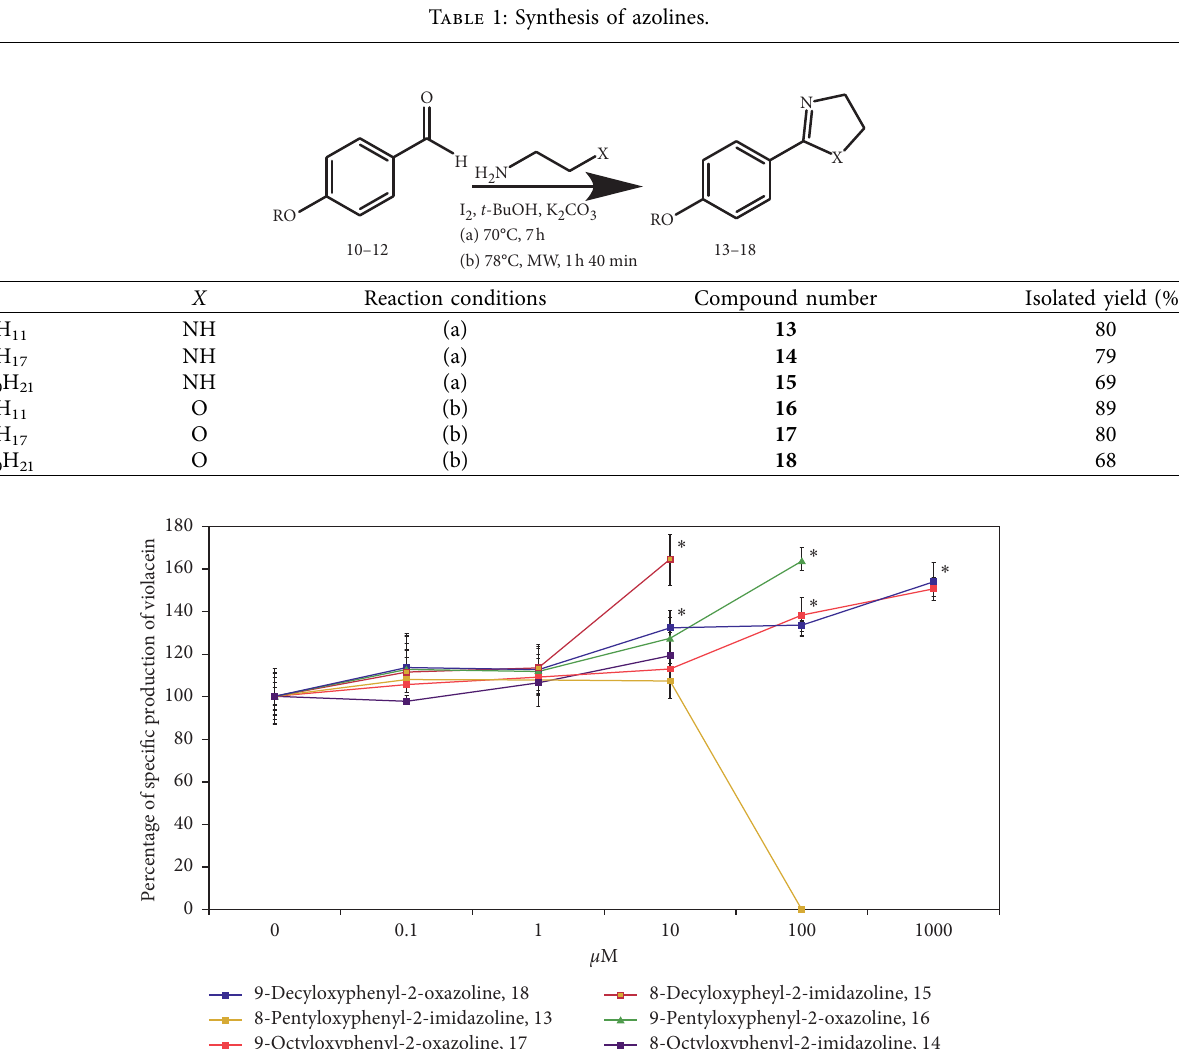
Figure 2: Production of violacein upon exposure to azolines 13 – 18 . Asterisks denote statistically significant